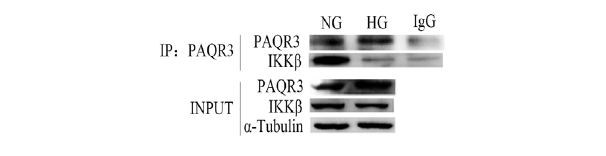
FigUre 7 | High glucose (HG) stimulation attenuated the interaction between progestin and adipoQ receptor 3 (PAQR3) and IKK β . Immunoprecipitation assay was applied to detect the interaction between PAQR3 and IKK β under NG and 1 h of HG treatment. Independent experiments were performed at least three times with similar results.